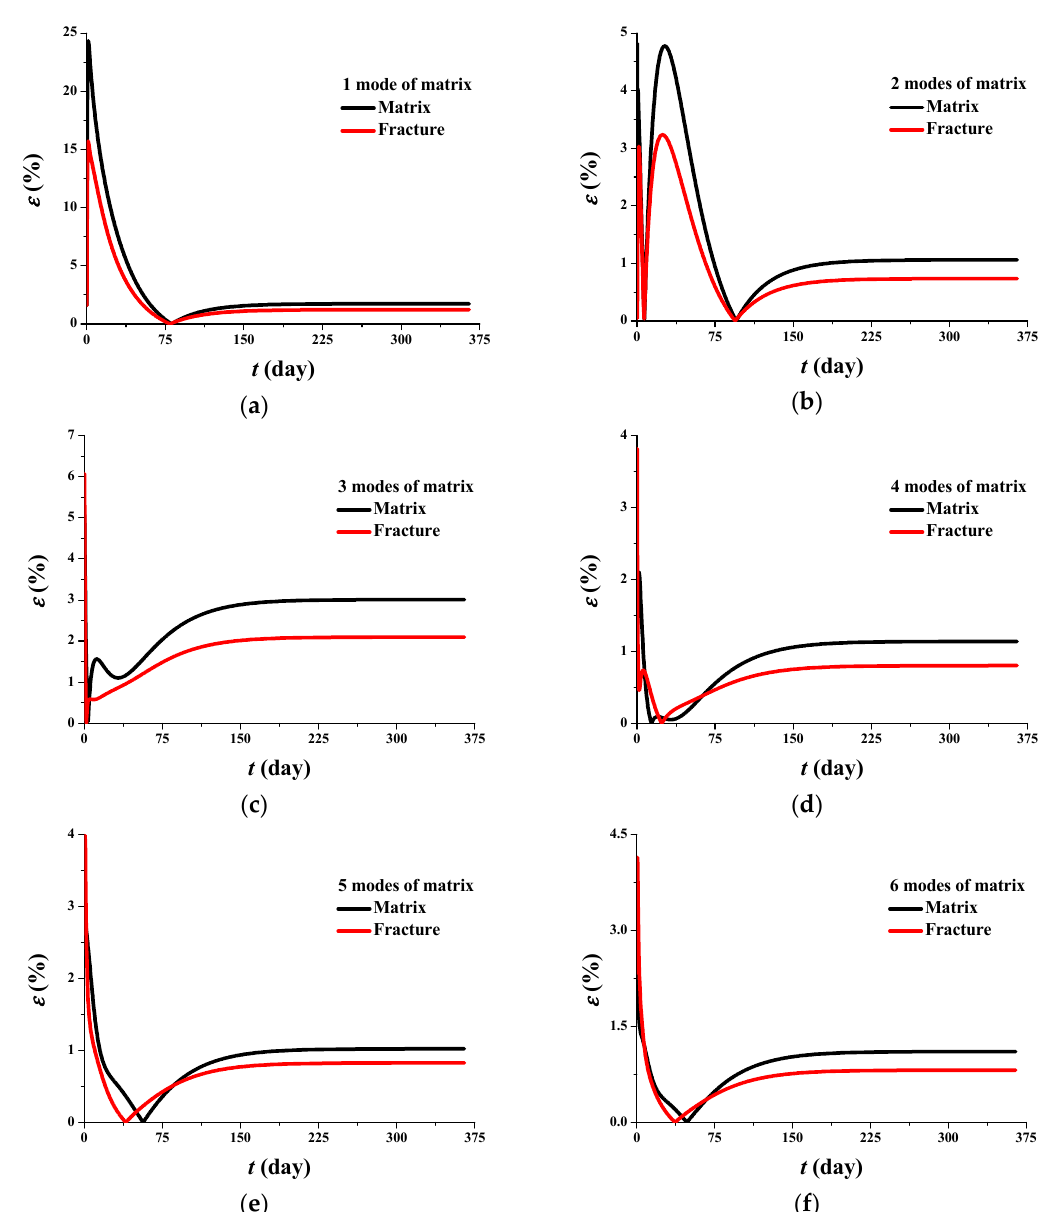
Figure 7. Relative errors of matrix and fracture pressures using the new POD modeling. ( a ) top 1 mode; ( b ) top 2 modes; ( c ) top 3 modes; ( d ) top 4 modes; ( e ) top 5 modes; ( f ) top 6 modes.